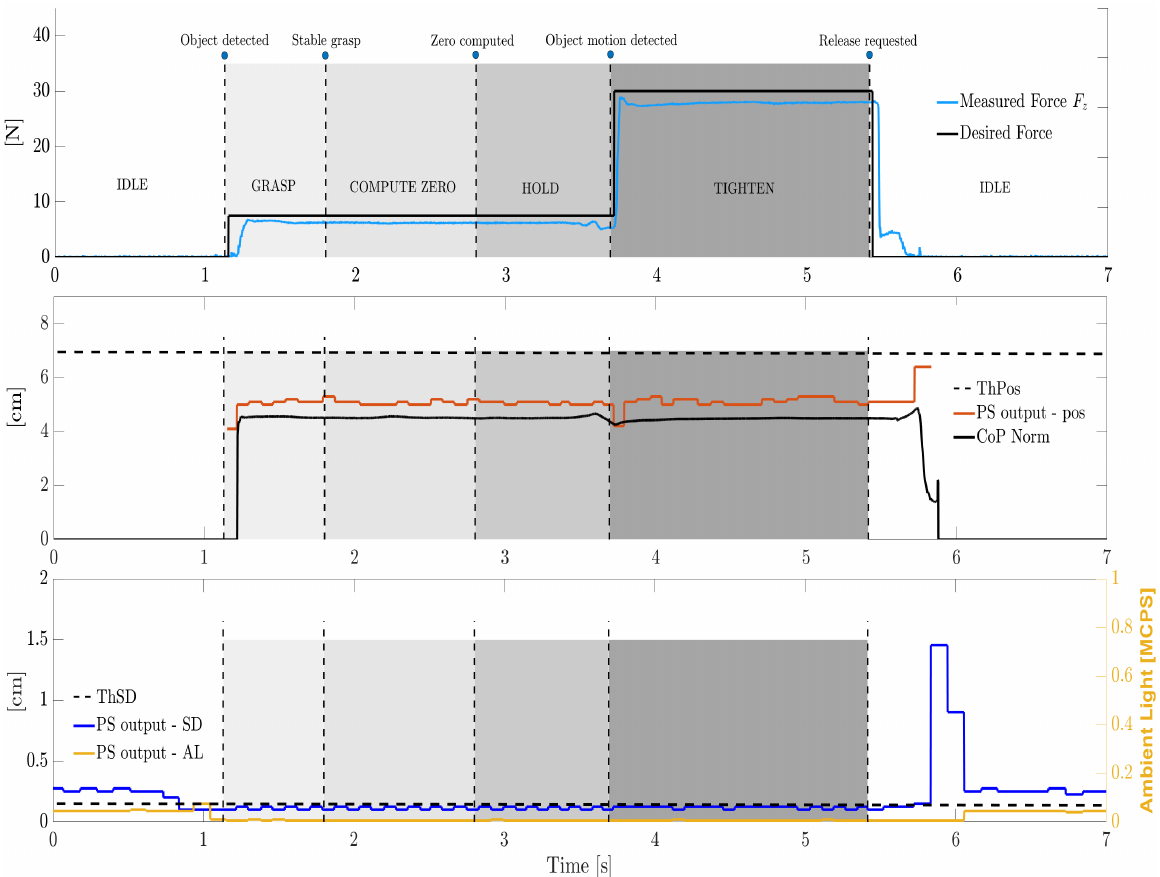
Figure 13. Representative trial on the holed metal piece, linear slip. The top subplot shows the desired and grasping forces, whereas the mid subplot shows the CoP variation together with the PS distance. The bottom subplot shows the AL and SD characterizing the PS signal. For the sake of clarity, labels of transitions and states are reported only in the top subplot whereas only some of the thresholds are